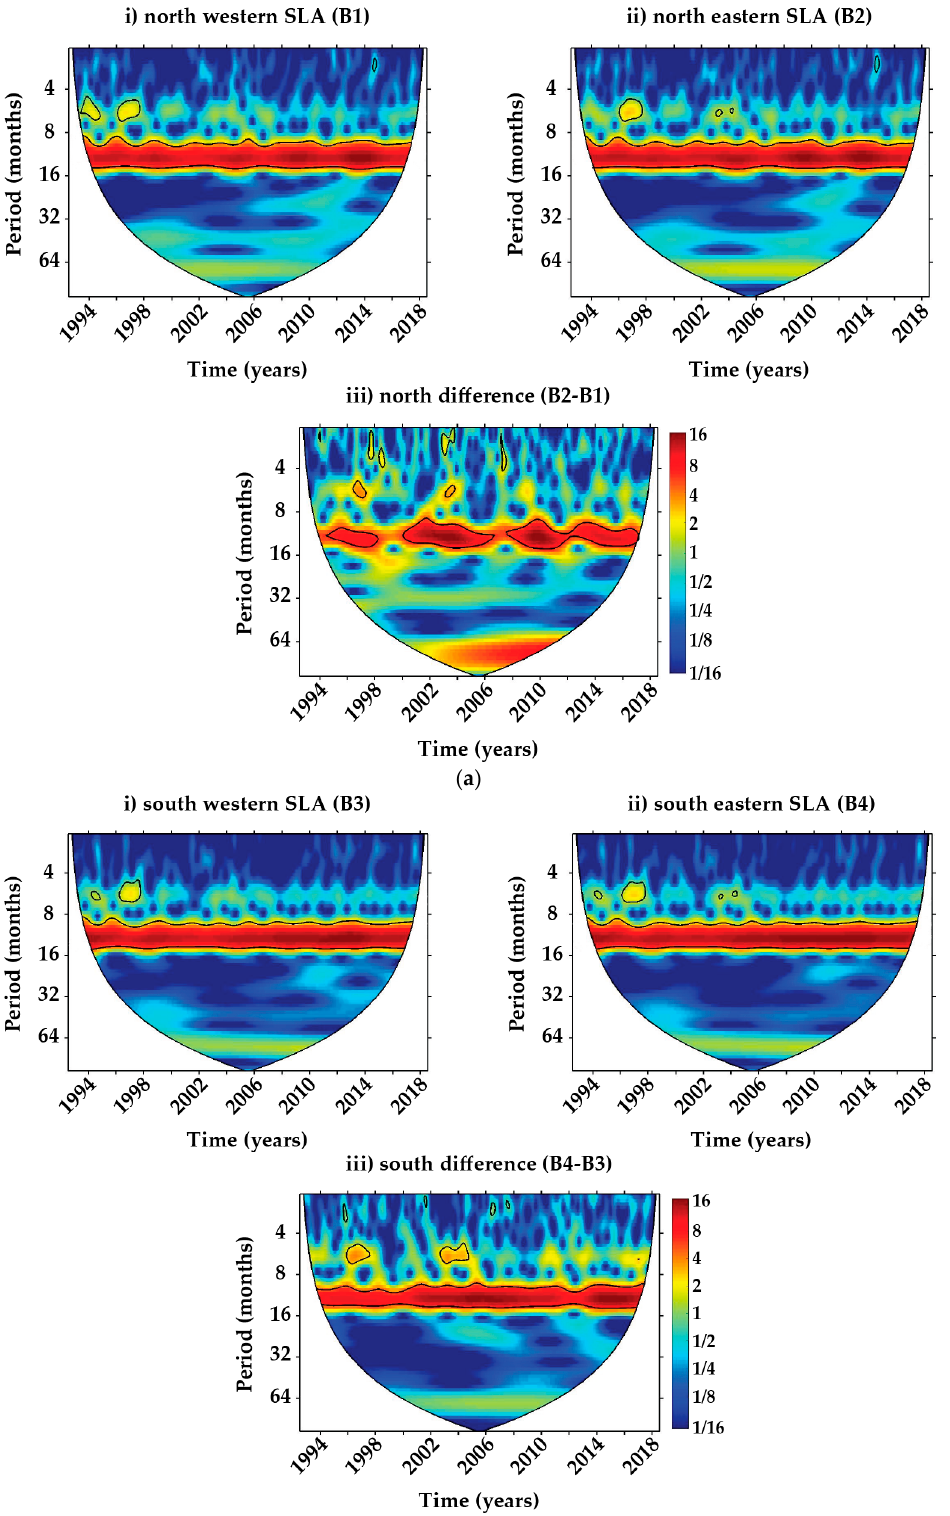
Figure 6. The wavelet plots for the western basin, eastern basin, and their di ff erence ( a ) for the northern Red Sea and ( b ) for the southern Red